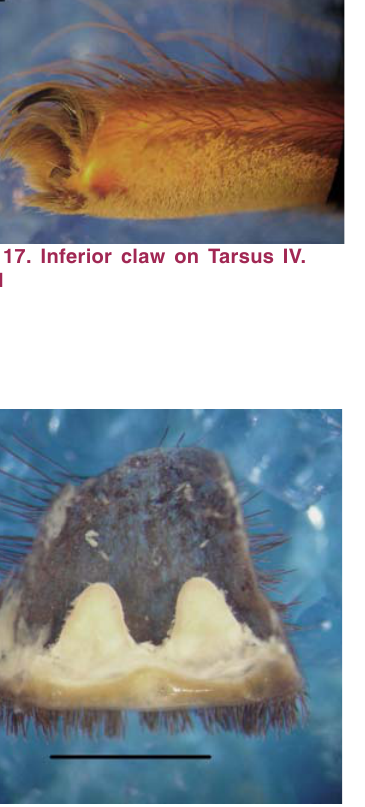
Image 21. Spermetheca of WILD-139. Scale Journal of Threatened Taxa | www.threatenedtaxa.org | June 2009 | 1(6): 331-339